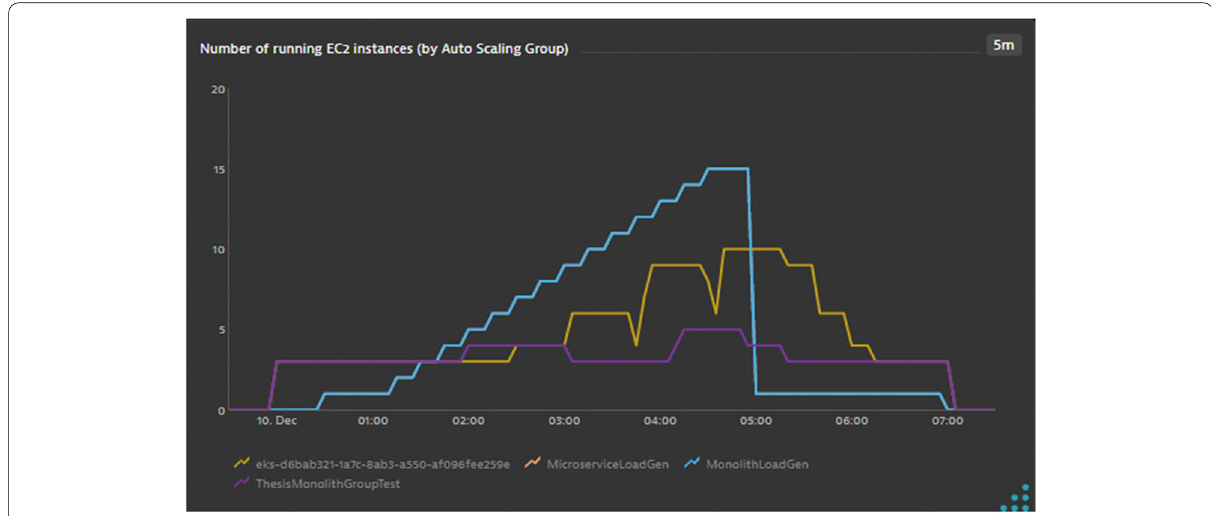
Fig. 31 Application scaling split by autoscaling